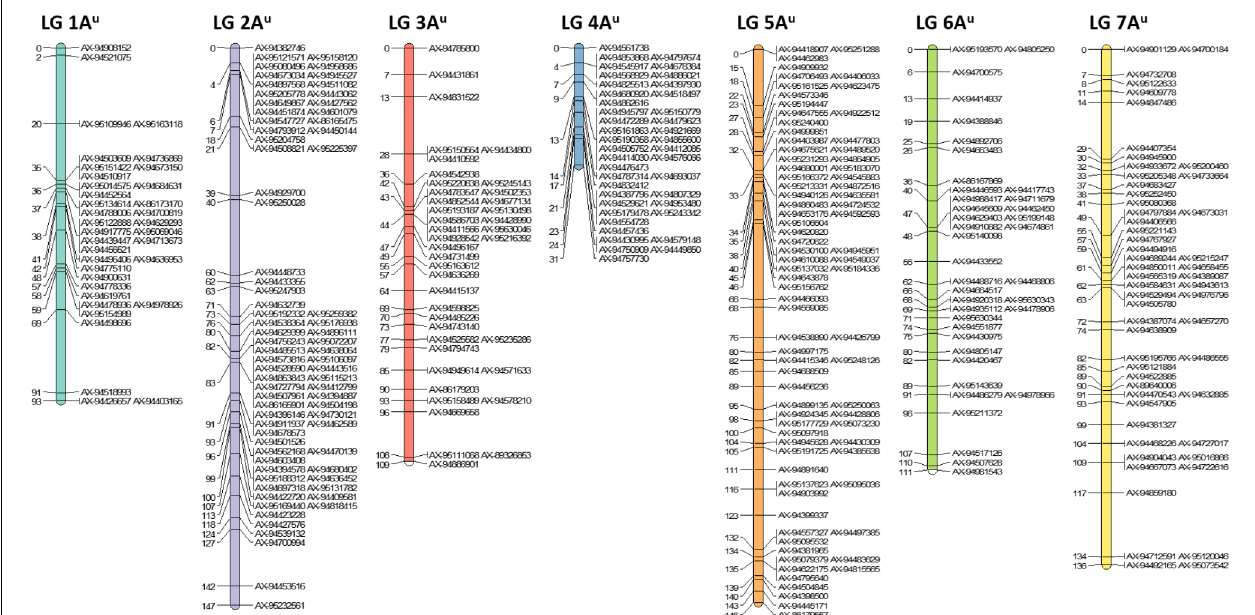
FIGURE 2 | Genetic linkage map of T. urartu showing 368 SNP markers spread across seven linkage groups (LGs).